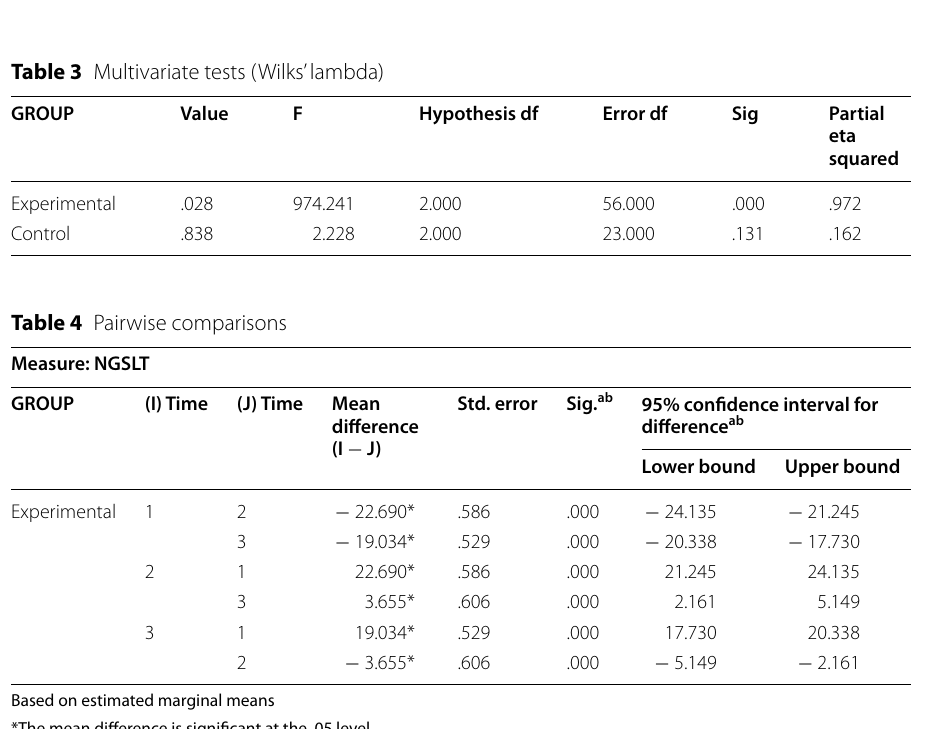
Table 3 Multivariate tests (Wilks’ lambda) GROUP